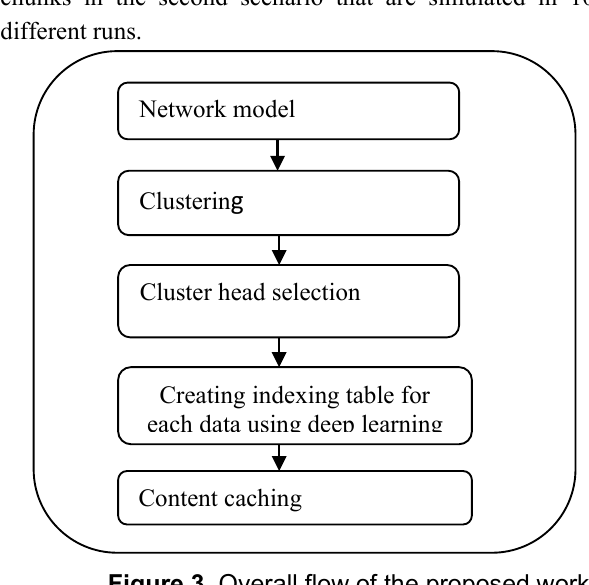
Figure 3. Overall flow of the proposed work The Zipf popularity model is selected with the _ value ranging from 0.5 to 1. Every time the topology is simulated for 120 seconds wherein the average of all 100 runs is combined as a final result. And in this section proposed model is compared with the existing methods to show the efficiency of the model in terms of energy efficiency, bandwidth consumption, Attack detection accuracy.